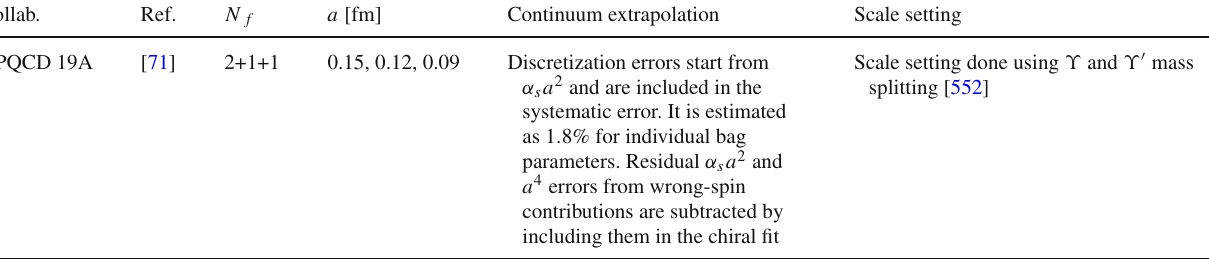
Table 149 Continuum extrapolations/estimation of lattice artifacts in determinations of the neutral B -meson mixing matrix elements for N f = 2 + 1 + 1 simulations Collab.